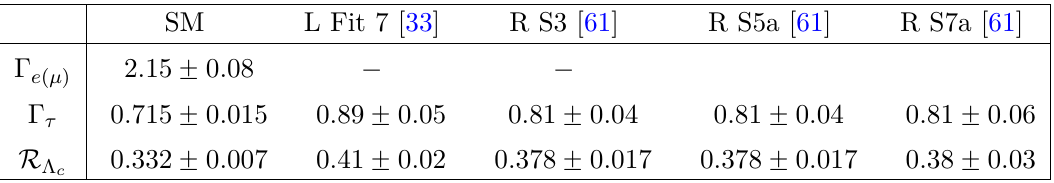
(cid:8) ¯ ν [units of e p µ q